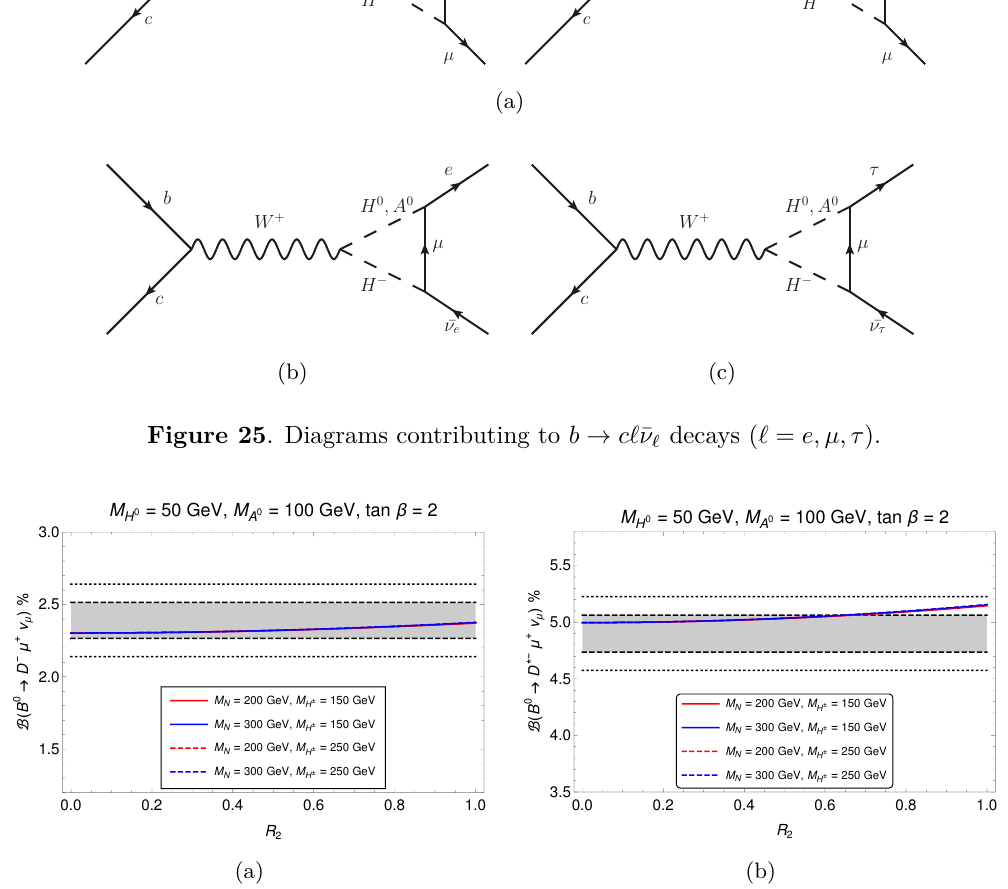
Figure 26 . Variation of the branching fraction of ¯ B → Dµ ¯ ν µ (figure 26(a)) and ¯ B → D ∗ µ ¯ ν µ (figure 26(b)) with R 2 for two different values of M N and M are kept fixed as shown in the plot labels. In both the plots, the gray shaded band is the measured branching fraction of the B -decays in their 1 σ CL respectively while the dotted lines denote the 2 σ allowed